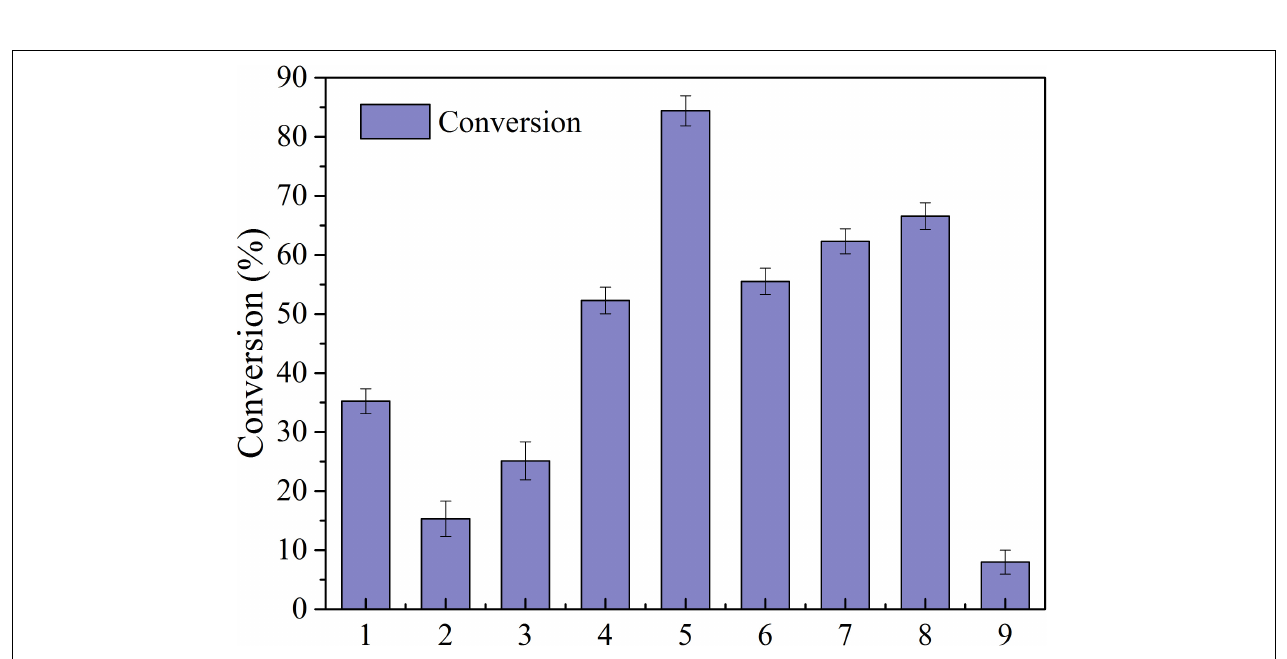
FIGURE 1 | Scheme of PNHE synthesis and high-performance liquid chromatography (HPLC) chromatogram. Peak 1 of HPLC chromatogram is NH, and peak 2 is PNHE.